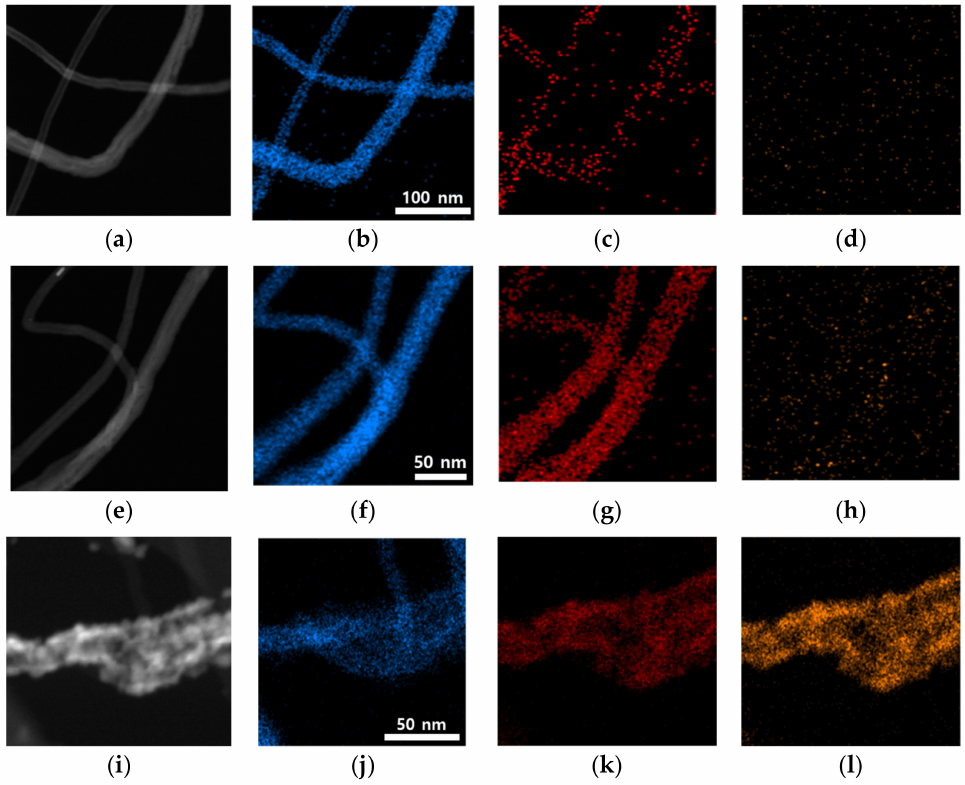
Figure 2. TEM images of each sample with controlled functional groups: ( a ) CNT; ( e ) t-CNT; ( i ) ZnO@CNT. Elemental mapping images for the carbon element of each sample: ( b ) CNT; ( f ) t-CNT; ( j ) ZnO@CNT. Elemental mapping images for the oxygen element of each sample: ( c ) CNT; ( g ) t-CNT; ( k ) ZnO@CNT. Elemental mapping images for the Zinc element of each sample: ( d ) CNT; ( h ) t-CNT; ( l ) ZnO@CNT.